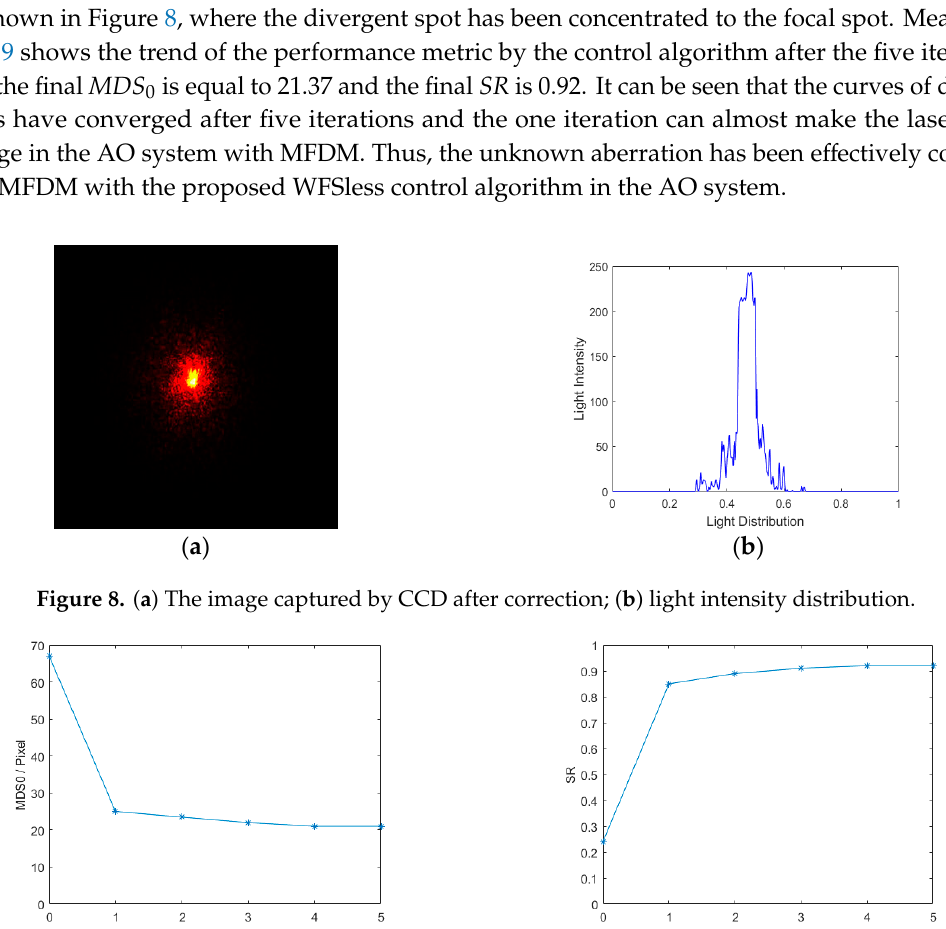
Figure 9. The trend of the performance metric ( a ) MDS 0 curve; ( b ) Sterhl ratio (SR)